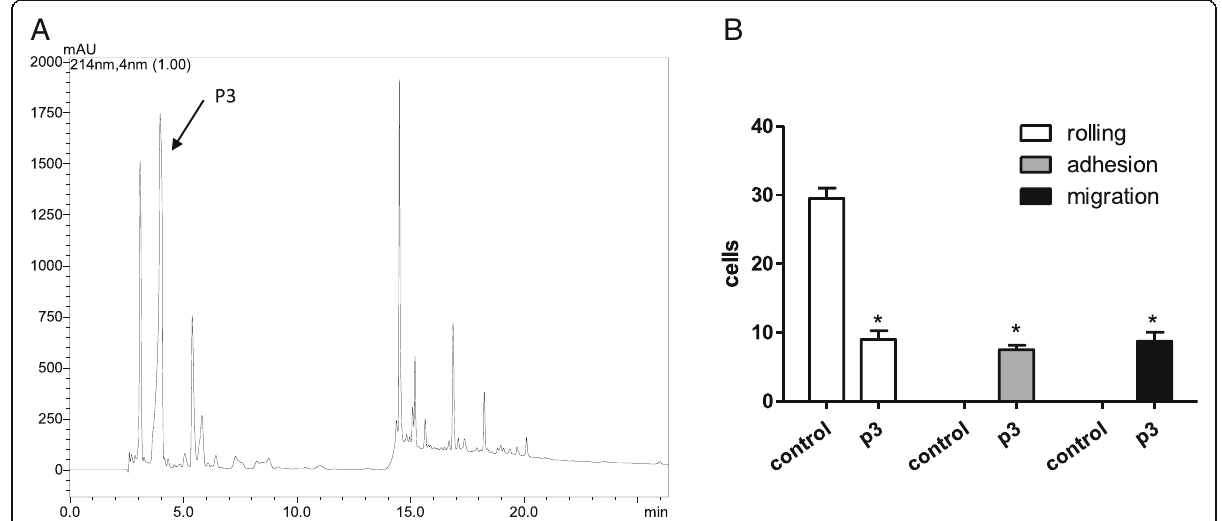
Fig. 2 Fractionation of SPE 25% and biological assay of its fractions. a RP-HPLC purification of 25% SPE fraction, in a C18 column, elution by 0 to 80% acetonitrile containing 0.1% TFA in water. In the arrow, the proinflammatory peak, named p3. b Leukocytes count on the cremaster muscle microcirculation 2 h after p3 injection. * p <